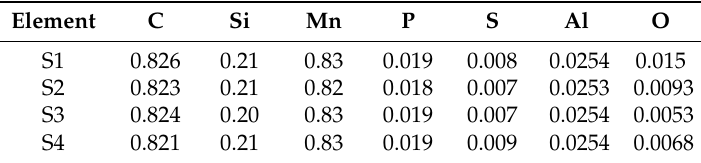
Table 1. Chemical composition of the test steel (weight precent / %). Element C Si Mn